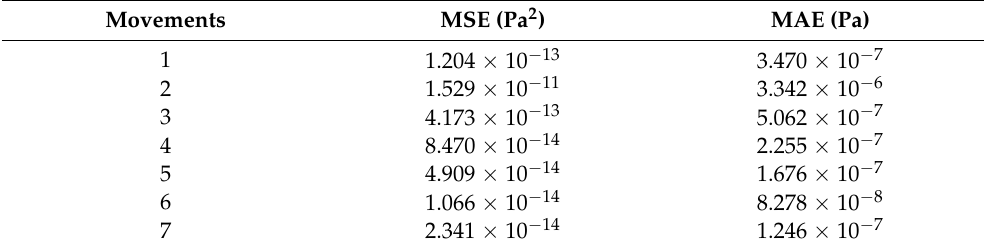
Table 2. Error of movement estimation for sectorization 1: dam and homogeneous